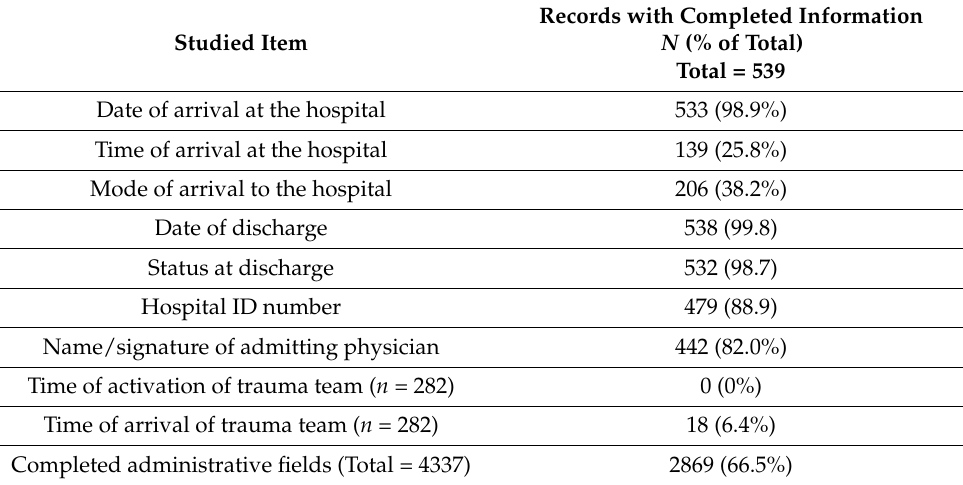
Table 2. Availability of administrative data in the medical records of trauma patients.